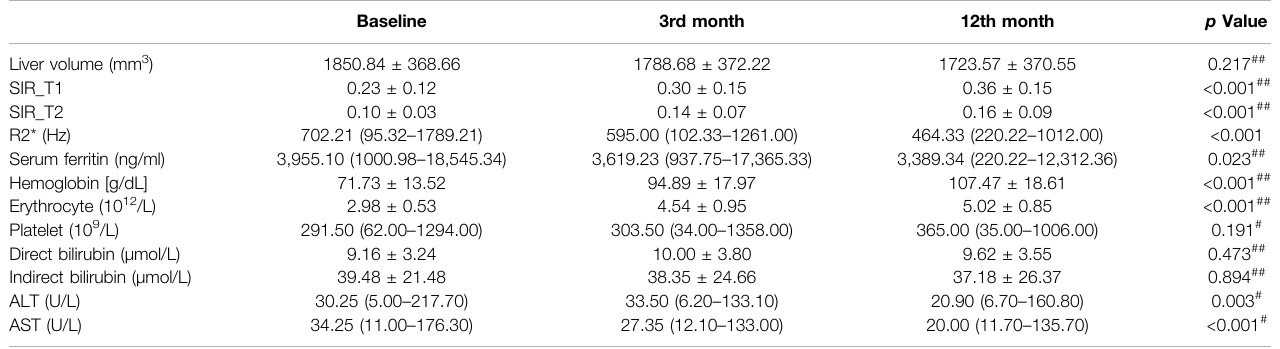
TABLE 1 | Liver volume, hepatic muscle signal ratio, R2*, and clinical characteristics of the 66 patients with transfusion dependent ß -thalassemia before thalidomide treatment and at the 3 rd month and 12th month after treatment. Baseline